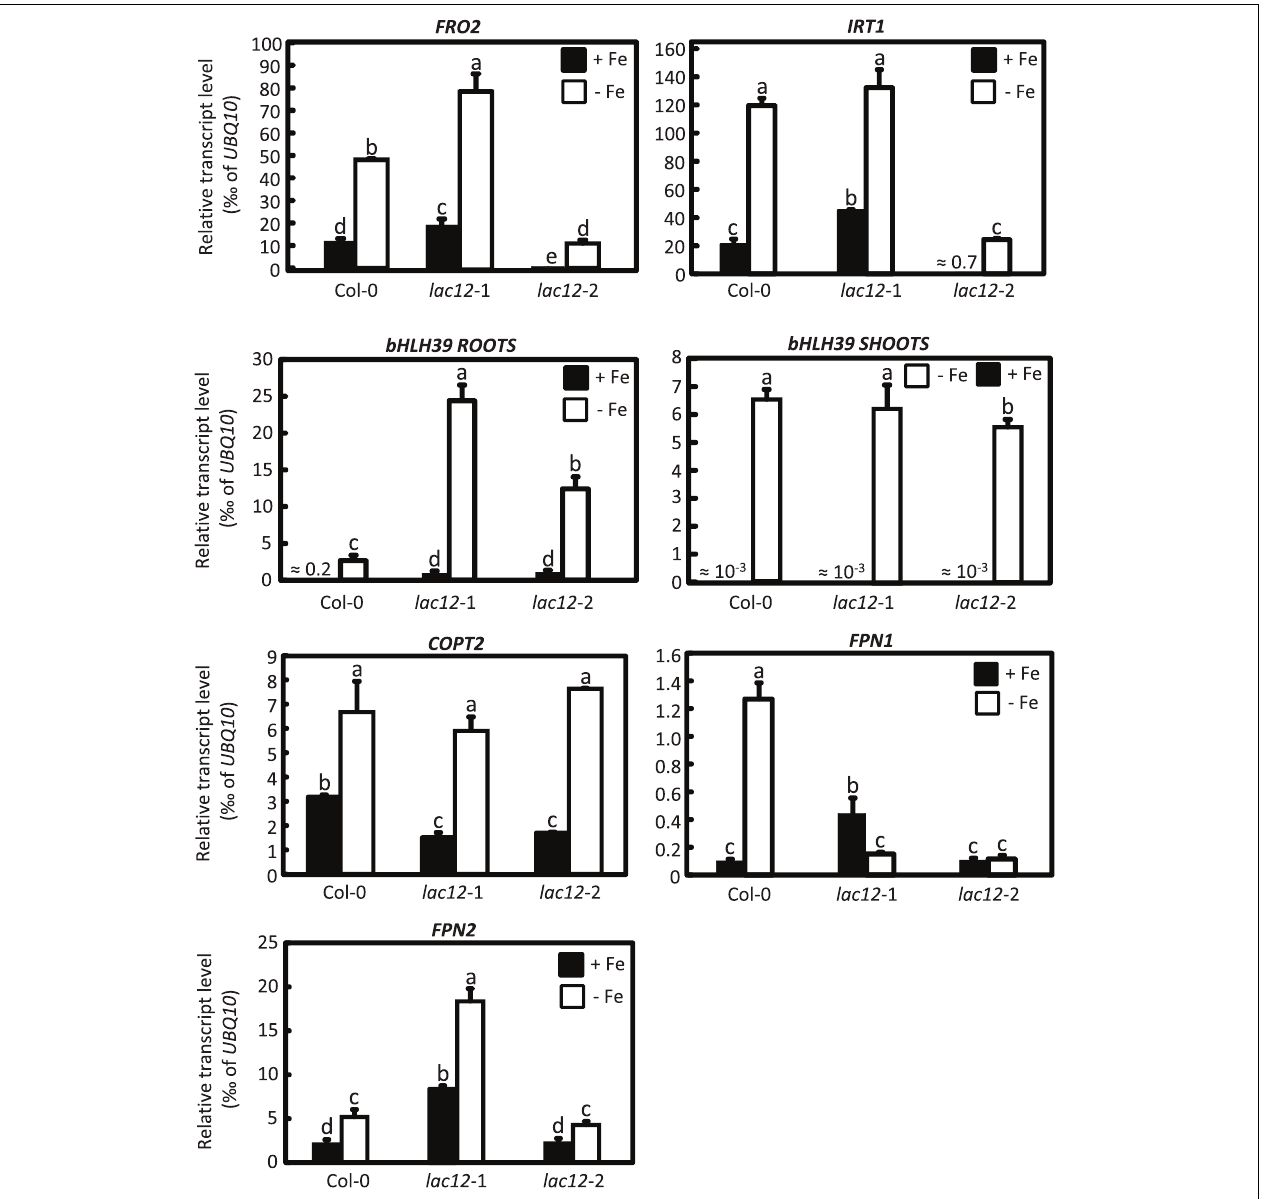
FIGURE 7 | Real time RT-qPCR quantification of several Fe-deficiency responsive transcripts in lac12 mutants. Relative transcript levels of FRO2, IRT1, bHLH39, COPT2, FPN1, and FPN2 in roots and bHLH39 in shoots of WT, lac12 -1 and lac12 -2 seedlings grown on vertically oriented petri plates as described in Figure 3 , analyzed by RT-qPCR. Bars show arithmetic means ± SD of relative transcript levels normalized to UBQ10 , and were calculated from n = 4 technical replicates from one experiment. Different characters denote statistically significant differences ( P < 0.05) between means based on ANOVA (Tukey’s